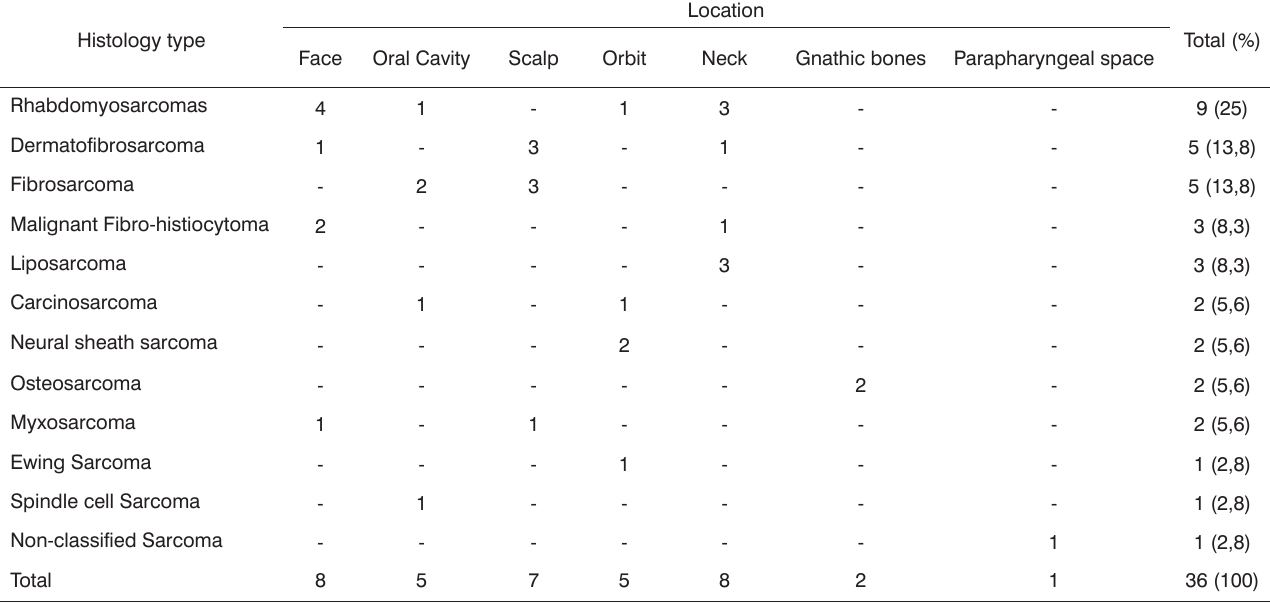
Table 2. Sample distribution according to histology type and